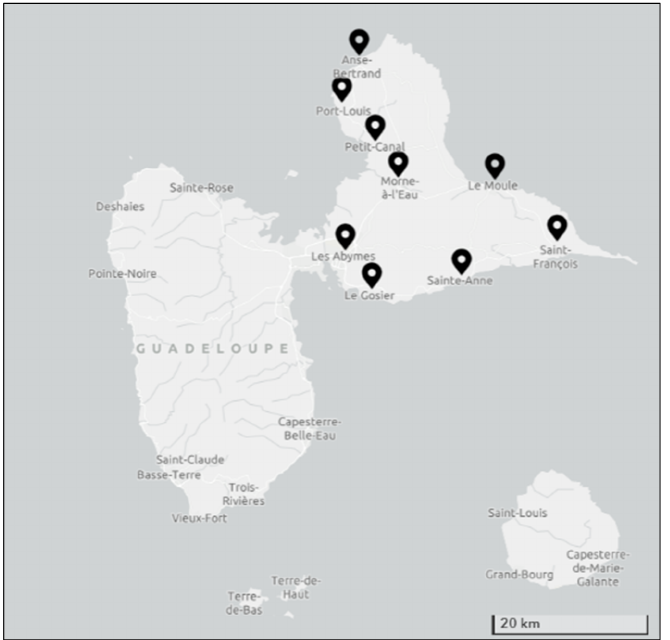
Figure 1. Geographical position of Grande-Terre. Nine different municipalities of Grande-Terre Island where the survey was conducted are shown in the map.